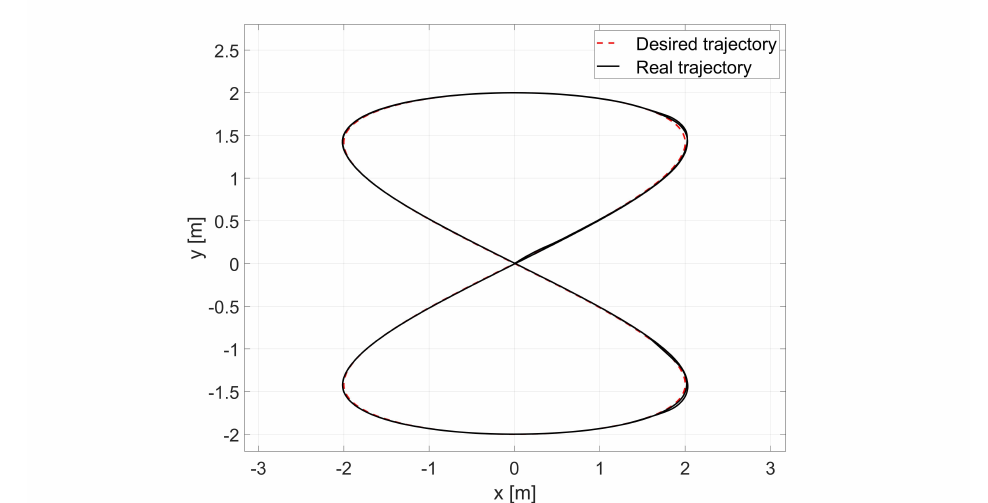
Figure 21. Comparison of the reference and real trajectories in the laboratory test of identification by the RLS method with the values of the initial parameters determined by the Levenberg-Marguardt method.